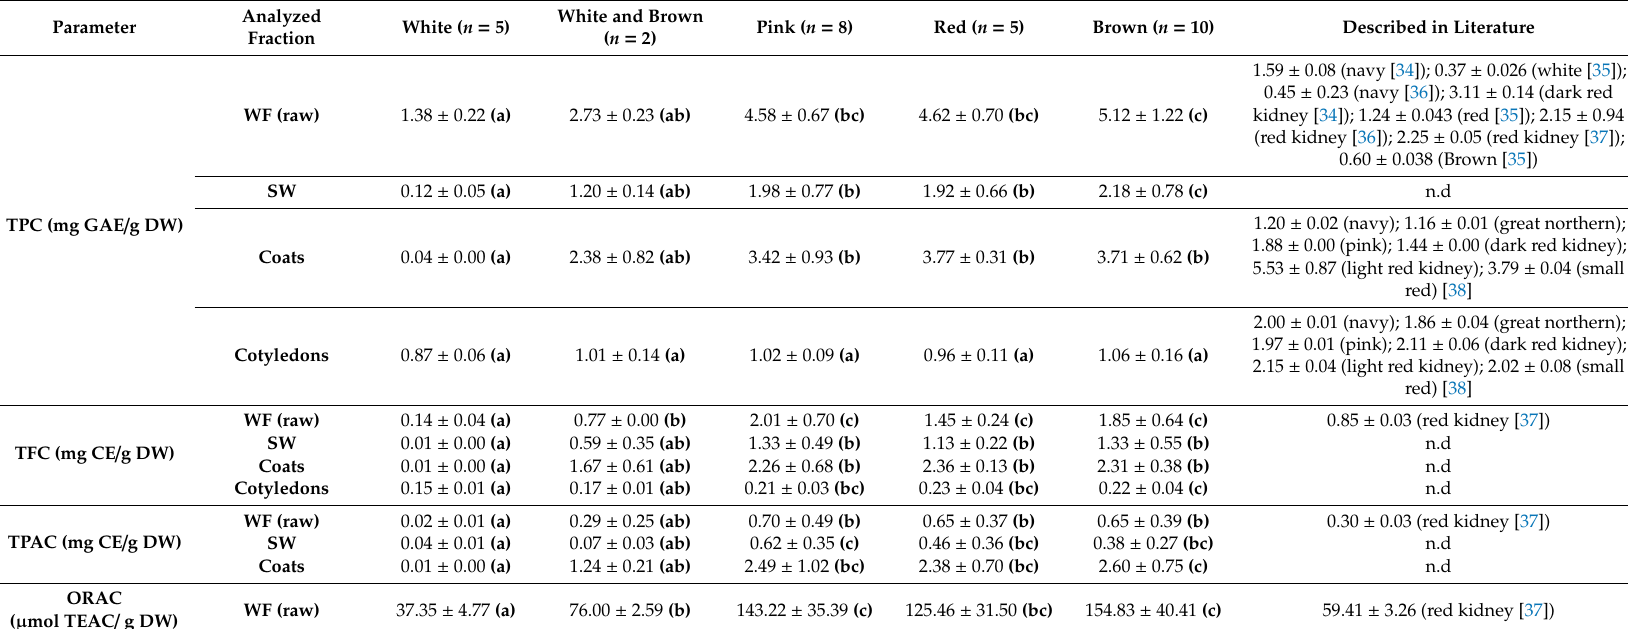
Equal letters per parameter (row) indicate absence of significant di ff erences between color classes ( p > 0.05); n.d. not